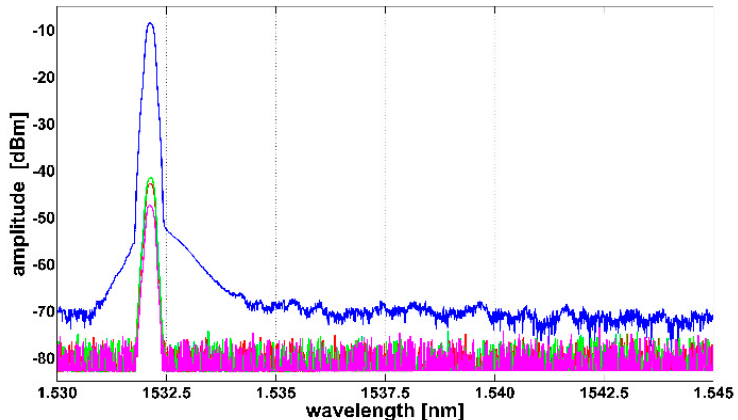
Figure 7. Recorded spectra of Channel 1 at the four WSS outputs (only the SOA gate of WSS1 was enabled).